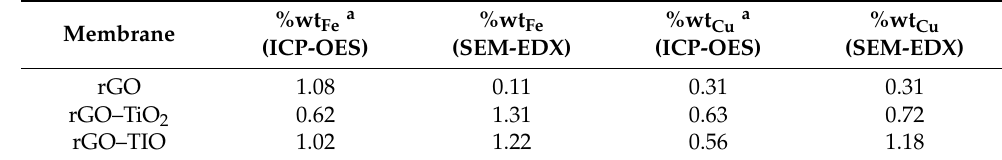
Table 4. Comparison of ICP-OES and SEM-EDX captured metal mass